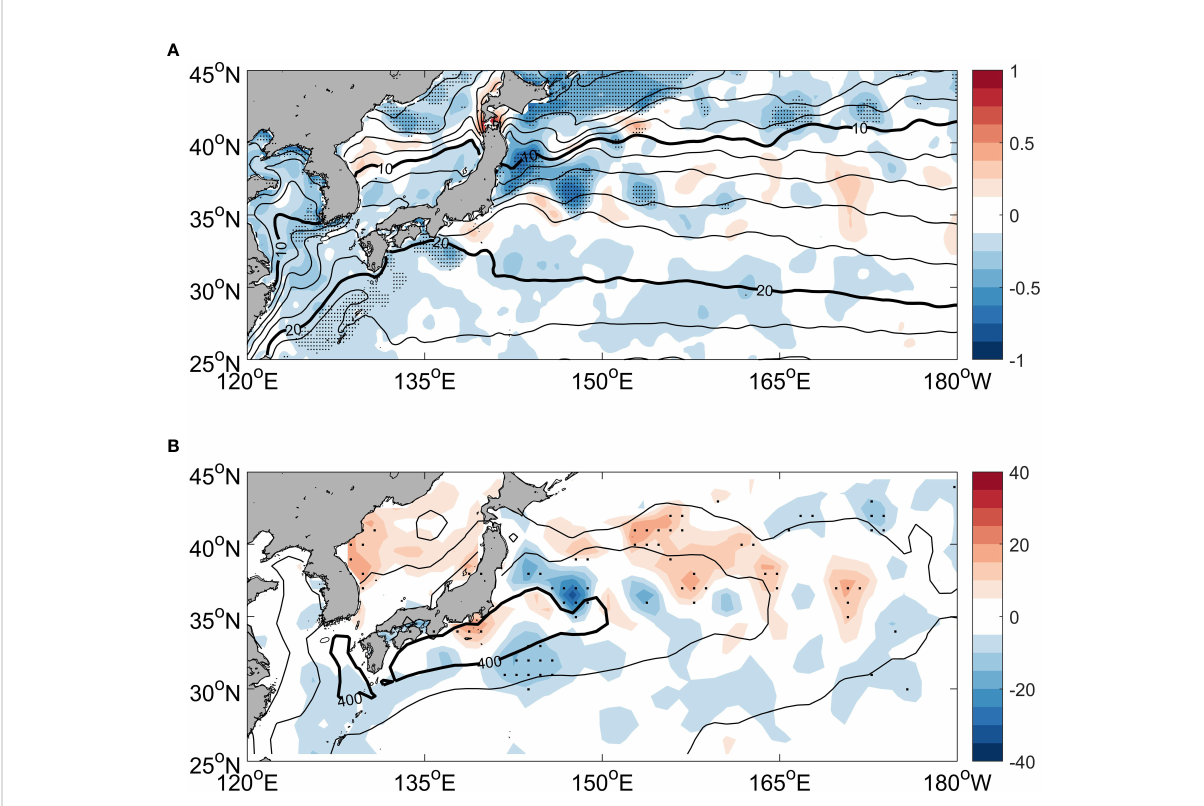
FIGURE 5 (A) The lagged regression of the SST anomaly (shading; unit, °C) in DJF onto the KEI 2 months earlier, overlapped with the winter background SST (contours with an interval of 2°C). The black thick contours highlight the SSTs at 10°C and 20°C. (B) The lagged regression of the THF anomaly (shading; unit, W m − 2 ) in DJF onto the KEI 2 months earlier, superposed by the winter background THF (contours with an interval of 100 W m − 2 ) in DJF with the black thick contours indicating the THF of 400 W m − 2 . A positive THF suggests that the THF transports from the ocean upward into the atmosphere. Stippling denotes where the anomalies are signi fi cant at the 90% con fi dence level. SST, sea surface temperature; KEI, Kuroshio Extension